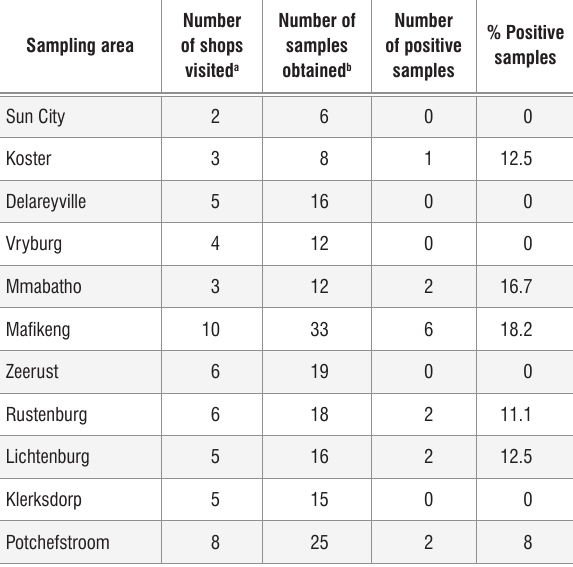
Number of Salmonella positive samples obtained from different locations Sampling area